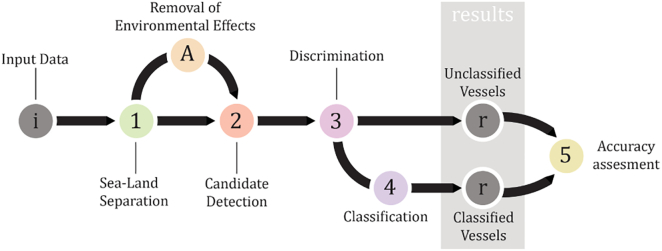
A common scheme of vessel detection workflow (generalisation from all gathered literature).